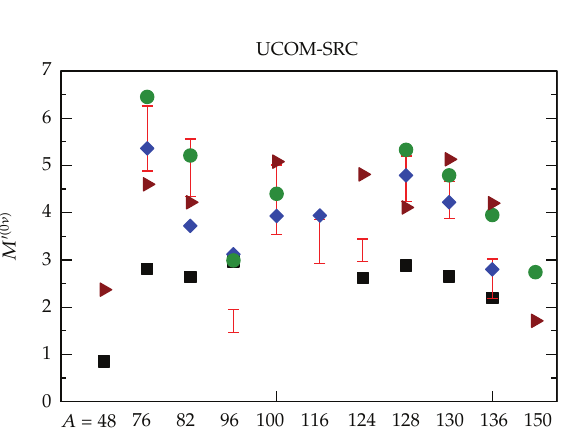
Figure 2: The neutrinoless double-beta decay; ”state-of-the-art” NMEs: QRPA (cid:5) 30 (cid:6) (cid:2) red bars (cid:3) and (cid:5) 21, 22 (cid:6) (cid:2) diamonds (cid:3) , ISM (cid:5) 31 (cid:6) (cid:2) squares (cid:3) , IBM (cid:5) 25 (cid:6) (cid:2) circles (cid:3) , and GCM (cid:5) 26 (cid:6) (cid:2) triangles (cid:3)